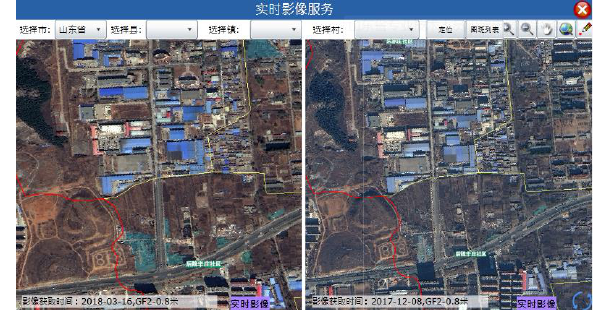
Figure 6. Image patrol function interface